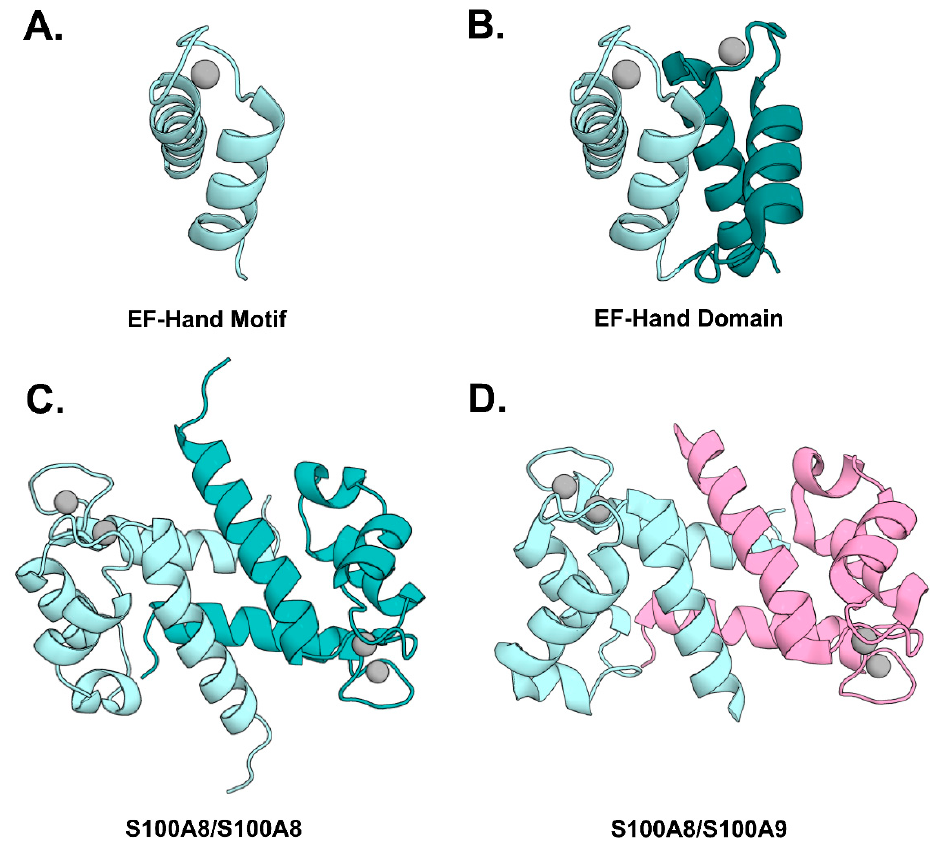
Figure 2. Structural features of S100 proteins: Upper left panel shows a helix–turn–helix EF-hand Ca 2+ -binding motif ( A ) and an EF-hand domain ( B ) (PDB entry 2H61). The lower panel shows the integration of two EF-hand domains in the S100A8 homodimer ( C ) (PDB entry 1MR8) and the S100A8–S100A9 heterodimer ( D ) (PDB